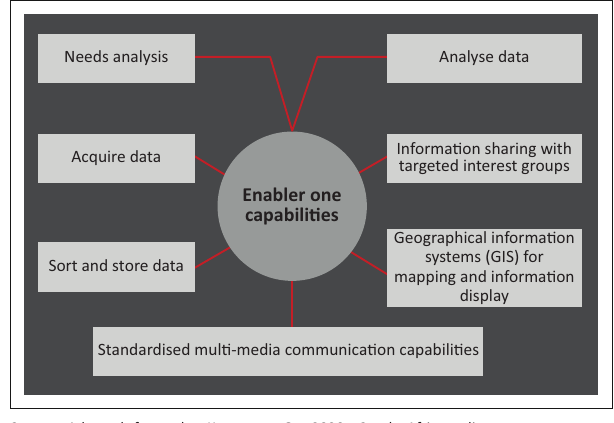
FIGURE 1: Capabilities for a full functioning information management and communication